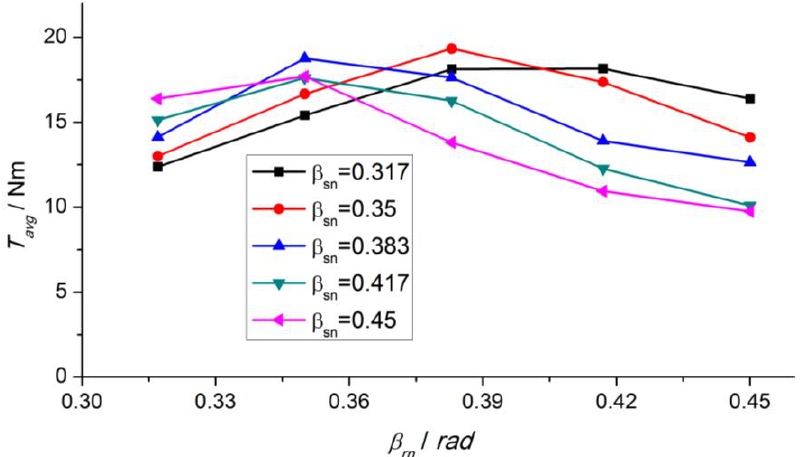
Figure 24. The curves of average electromagnetic torque with different β sn and β rn .